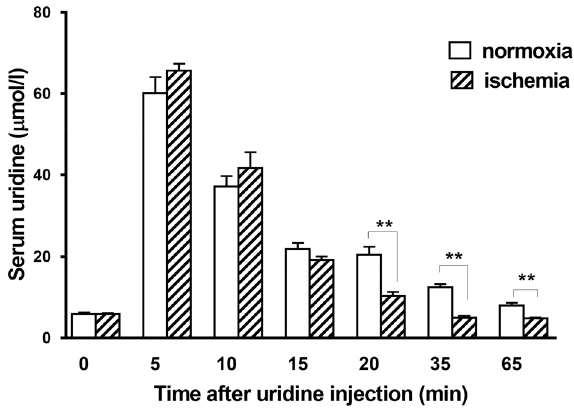
Figure 1. Levels of serum uridine after the intravenous administration of the nucleoside to rats in the control group (normoxia, n = 6) and in the group of animals with acute myocardial ischemia (AMI, n = 6). Uridine was given at a dose of 30 mg/kg five min before AMI. The determination of uridine in rat blood serum by HPLC was carried out at the following time points: 0 (background level), 5, 10, 15, 30, and 65 min after uridine administration. Data shown are the mean ± SD ( n = 6). ** p < 0.01 (vs. normoxia